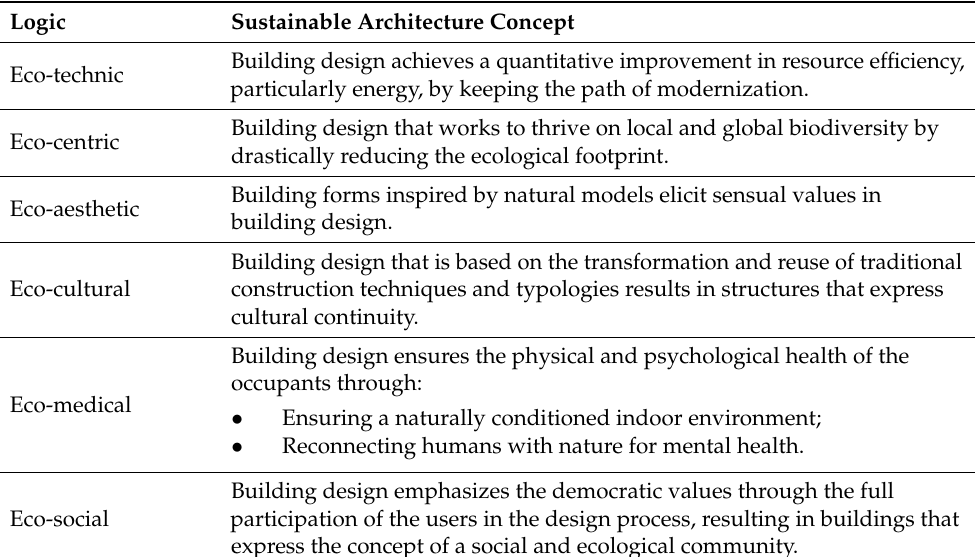
Table 1. The sustainable architecture concepts introduced by Guy and Farmer